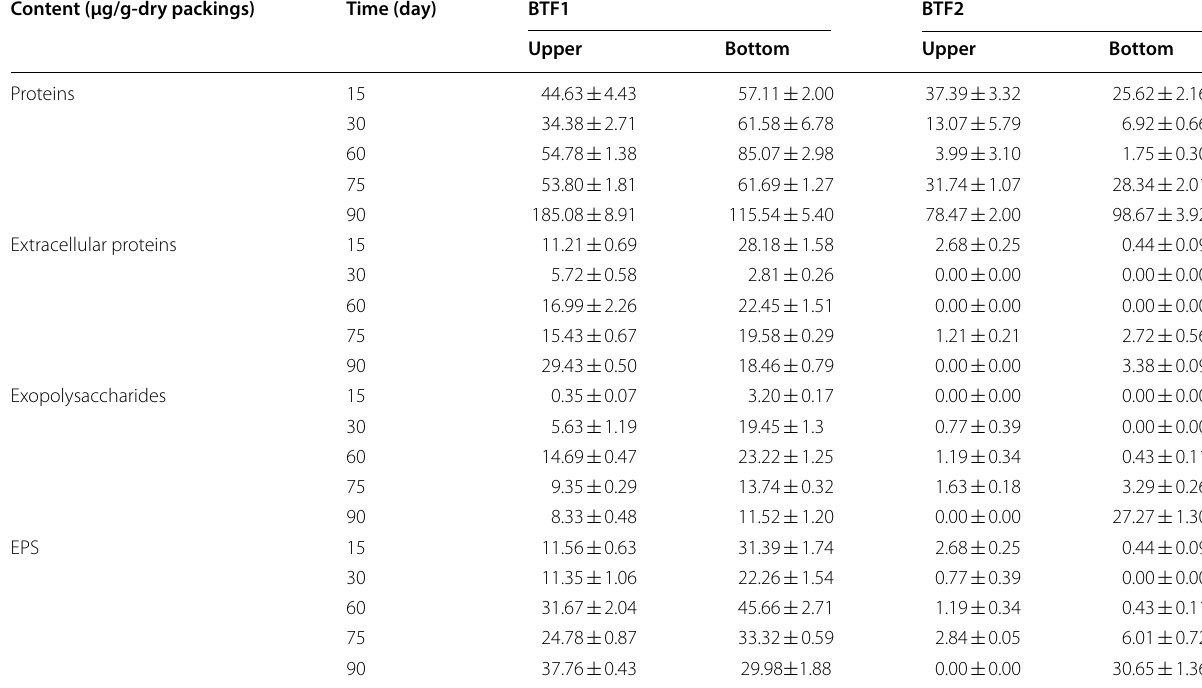
Table 2 Biomass and EPS content during the operating days Content (μg/g‑dry packings) Time (day) BTF1 BTF2 Upper Bottom Upper Bottom Proteins